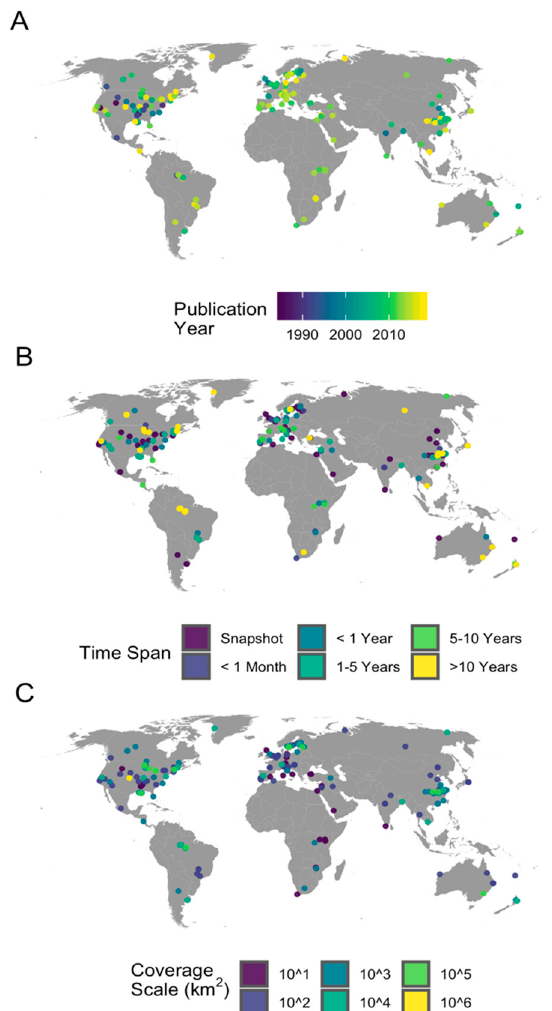
Figure 6. Spatial distribution of study publication date ( A ), timespan ( B ), and spatial scale ( C ).